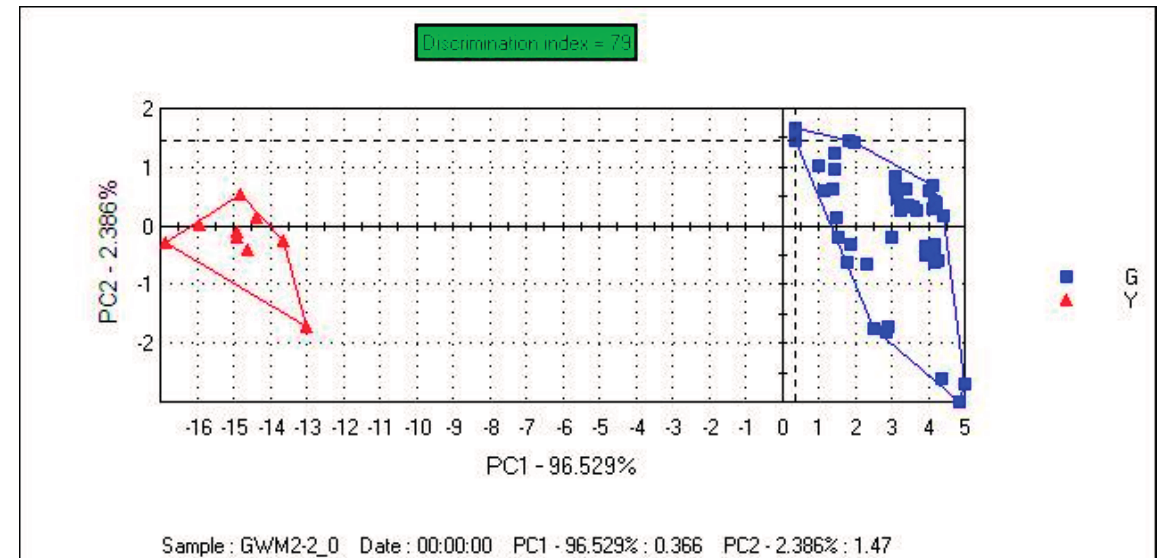
Figure 6. Principal component analysis (PCA) scatter plot for samples